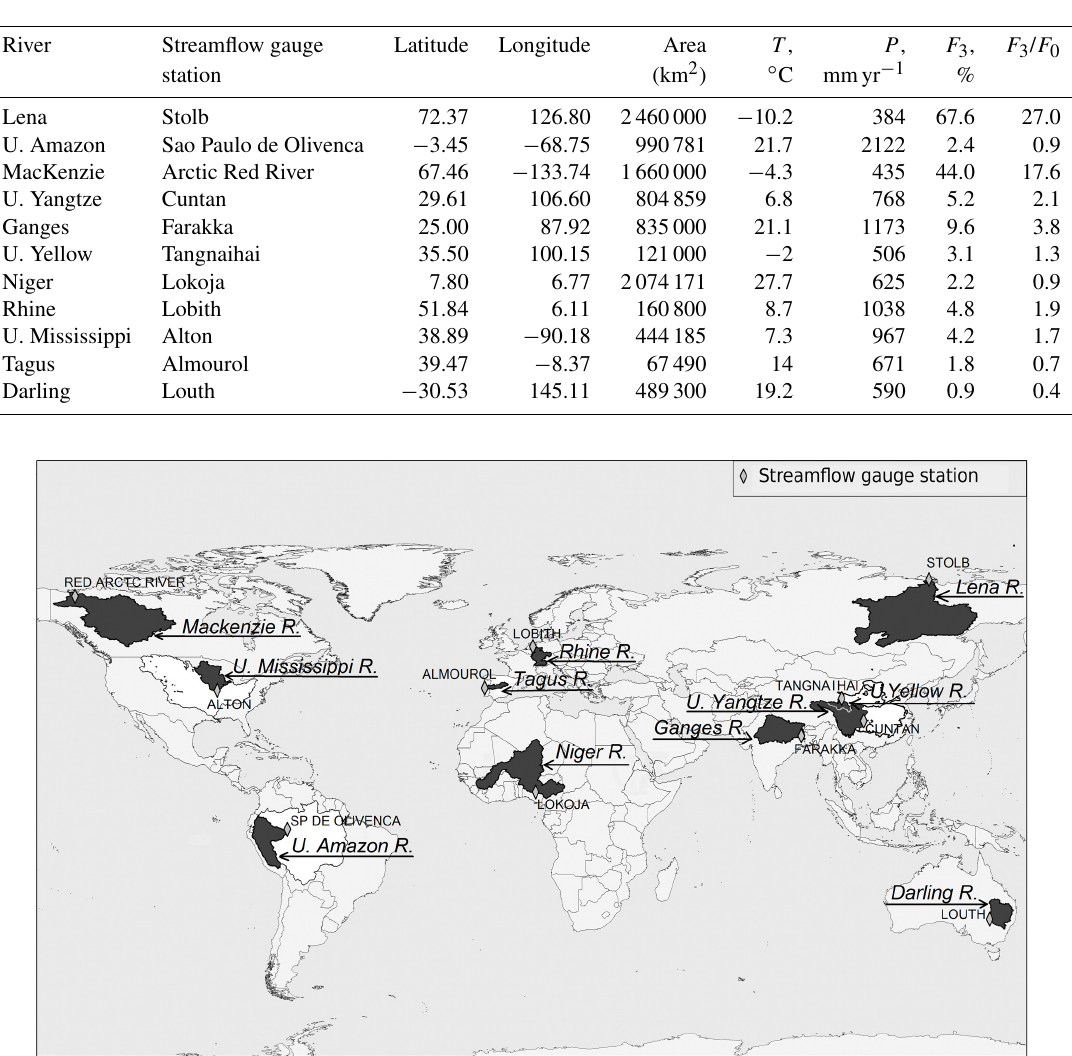
Table 1. River basins with their area; gauge stations with coordinates; averaged over 1971–2000 air temperature T and precipitation P ; change in the probability of extremely high runoff due to climate change (in accordance with RCP scenarios). The values of T and P are taken from (Krysanova and Hattermann, 2017); F 3 is the probability of extremely high runoff for the period P3, F 0 is the probability of extremely high runoff for the period P0, equaled to 2.5%.